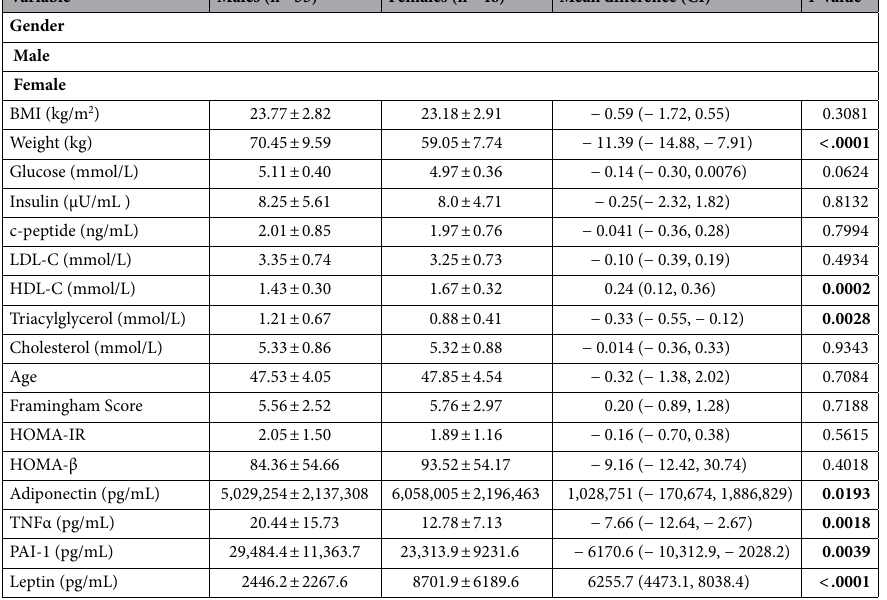
Table 1. Demographic and clinical characteristics at baseline (fasting state) for males versus females. P value from 2-sample t test for continuous variables and Fisher’s exact test for categorical variables. BMI, Body mass index; LDL-C, Cholesterol in low-density lipoprotein; HDL-C, Cholesterol in high-density lipoprotein; HOMA-IR, Homeostasis model assessment of insulin resistance; HOMA-β, Homeostasis model assessment